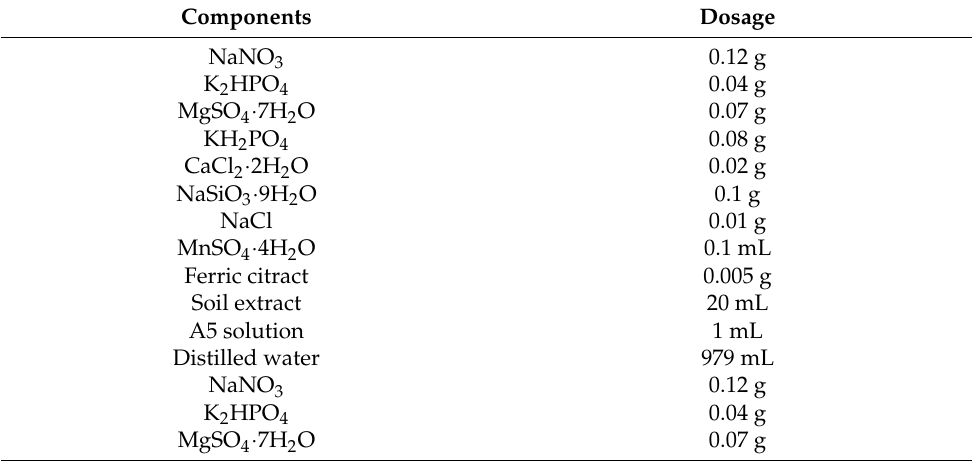
Table 1. Medium components of D1.